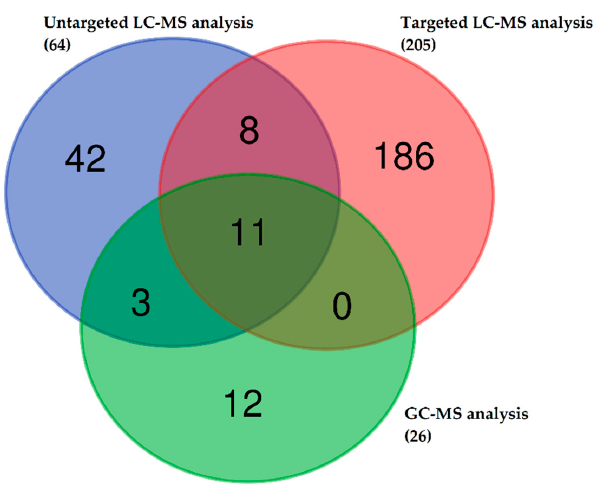
Figure 1. Venn diagram showing the number of metabolites identified in serum samples of